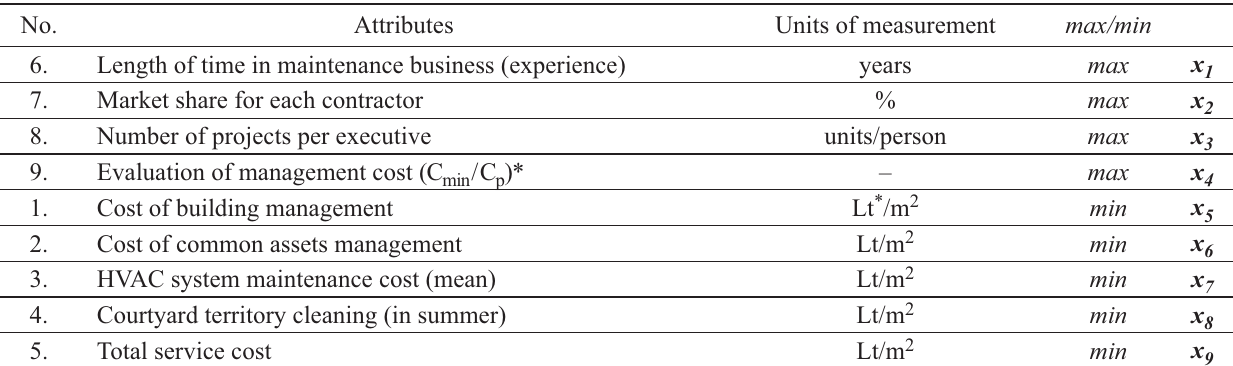
Table 1. Main attributes and objectives of maintenance contractors of dwellings in Vilnius